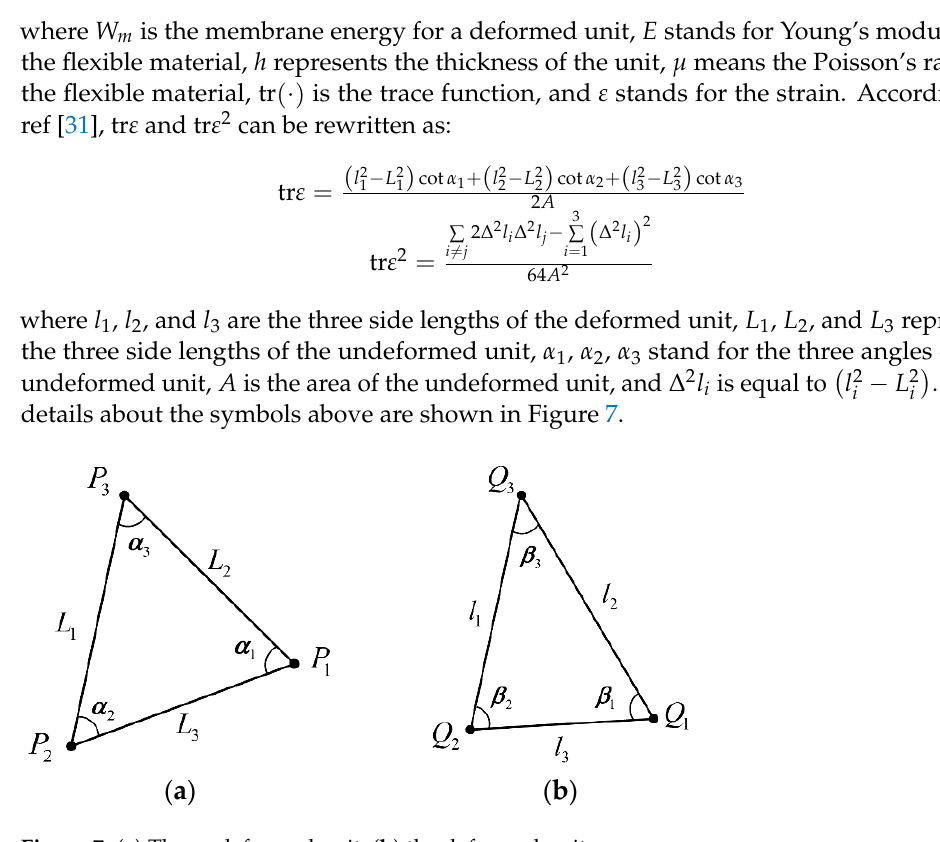
Figure 6. The units of the flexible lander.